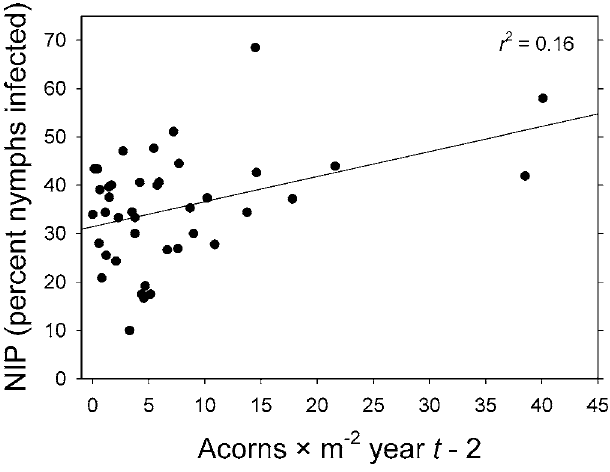
Figure 3. Effects of Acorn ( Quercus spp.) Density on NIP Shows effects of acorns per square meter in year t (cid:1) 2 on NIP (percentage of nymphs infected with B. burgdorferi ) in year t. This regression model for NIP had the most support. DOI: 10.1371/journal.pbio.0040145.g003